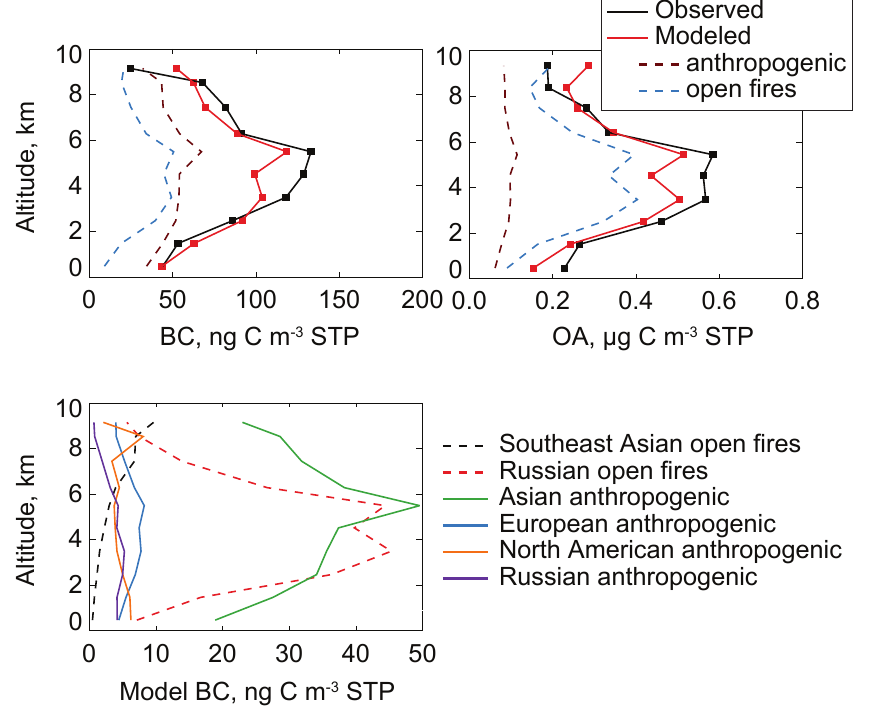
Fig. 7. Mean vertical profiles of BC and OA concentrations along the DC-8 flight tracks in ARCTAS (1–19 April 2008), averaged over 1-km altitude bins. The top panels compare observations to GEOS-Chem and separate the model contributions from anthropogenic and open fire sources. The bottom panel further separates model BC contributions by source regions. Anthropogenic sources include fossil fuel and biofuel